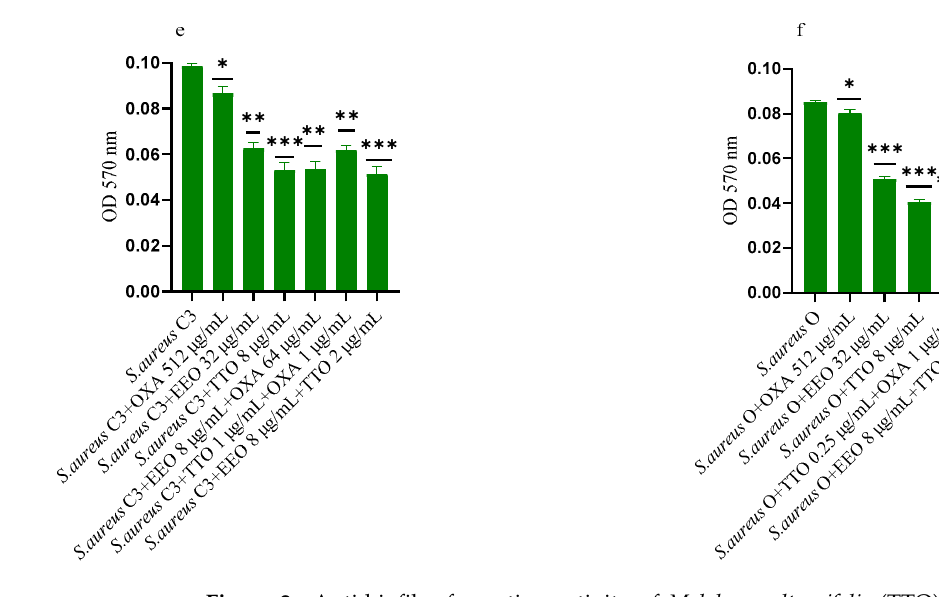
Figure 2. Anti-biofilm formation activity of Melaleuca alternifolia (TTO) and Eucalyptus globulus (EEO) EOs, of antimicrobials (cefotaxime -CTX-, vancomycin –VAN- and oxacillin-OXA-), and of different combinations/association (antimicrobial/EO and EO/EO) against ( a ) ESBL Escherichia coli 22 BT, ( b ) ESBL Escherichia coli 45DT, ( c ) VRE Enterococcus faecium A29, ( d ) VRE Enterococcus faecalis VAN3 ( e ) MRSA Staphylococcus aureus C3 and ( f ) MRSA Staphylococcus aureus O strains. Results were expressed in optical density (OD) 570 nm as the arithmetic mean of the three determinations. p -values of <0.05 (*), p < 0.01 (**), p < 0.001 (***) were considered significant by t -test and ANOVA using statistical program GraphPad Prism 9.2.0 (San Diego, CA, USA). ns stands for not statistically sig-